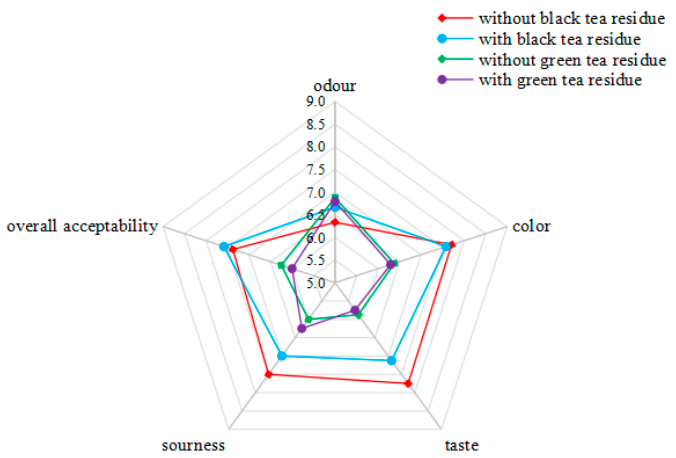
Figure 8. Sensory